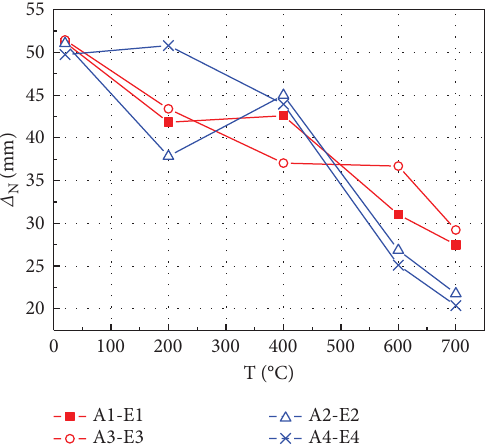
Figure 6: Te relationship between ultimate displacement and